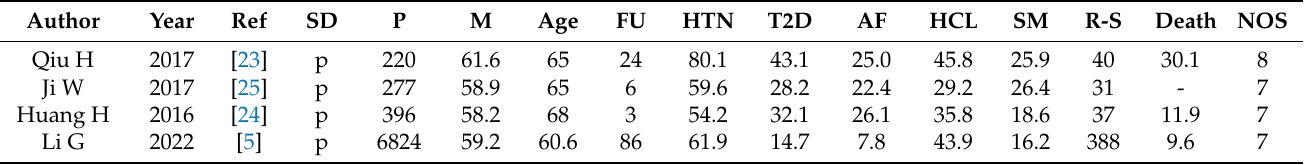
Figure 1. Stepwise procedure for selection of the studies. Table 1. Main characteristics of the study populations included in